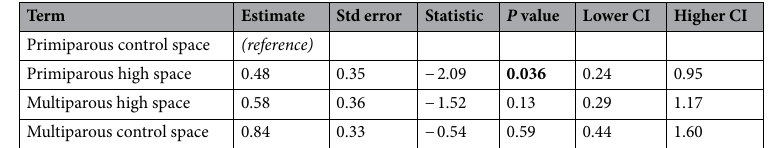
Table 4. Parameter estimates from the Cox proportional hazards model using data from cow-pairs using data from a year-long randomised controlled trial to evaluate the impact of living space on dairy cows that were non-pregnant at trial entry by trial-parity group. Significant values are in